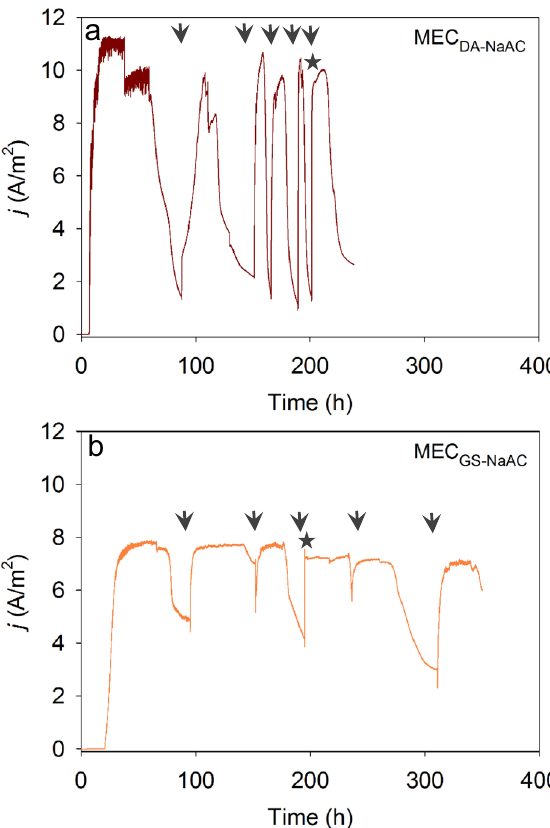
Fig. 1 Amperometric response of bio fi lms grown on carbon cloth anode under a set anode potential of − 0.1 V vs. Ag/AgCl and with acetate as the sole carbon and energy source. Amperometric response of a D. acetexigens (MEC DA-NaAc ) and b G. sulfurreducens (MEC GS-NaAc ) anode bio fi lms. Arrows indicate the change of feed. The fi rst two batches were fed with 10 mM acetate containing growth medium, and the remainder of the batches were fed with 6 mM acetate. The asterisk indicates the time when the bio fi lms were subjected to cyclic voltammetry analysis. The current densities represent the average of triplicate MECs.